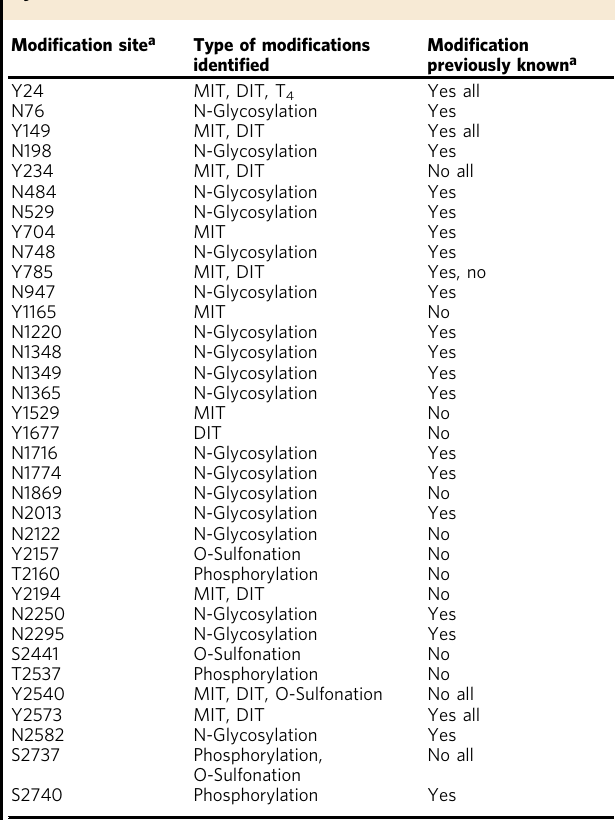
establish contacts to adjacent domains other than the type 1 Table 1 List of human thyroglobulin modi fi cations identi fi ed